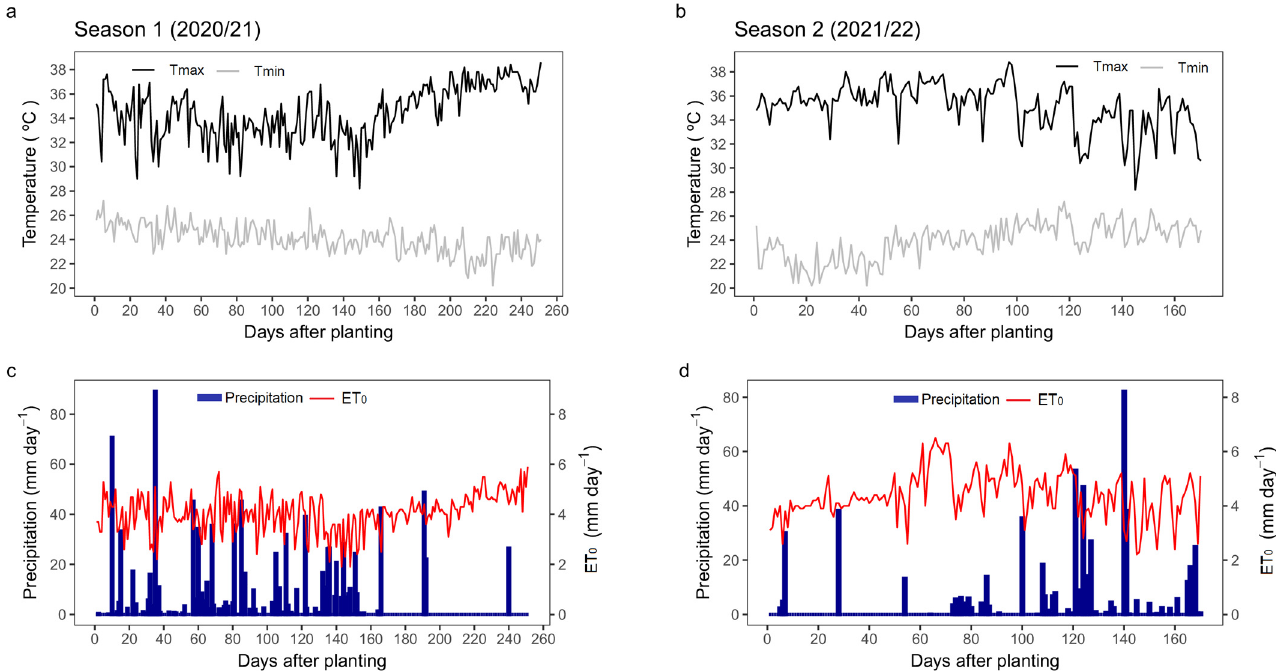
Figure 2. Daily weather data during the experiment for calibration and validation of the AquaCrop model for Megathyrsus maximus cv. Agrosavia sabanera at the Motilonia Research Center (Cesar, Colombia), season 1 from 19 June 2020 to 24 February 2021 and season 2 from 17 December 2021 to 4 June 2022. ( a ) Tmin and Tmax are the minimum and the maximum of daily air temperature in season 1; ( b ) Tmin and Tmax are the minimum and the maximum of daily air temperature in season 2; ( c ) Precipitation and reference evapotranspiration (ET 0 ) in season 1; ( d ) Precipitation and reference evapotranspiration (ET 0 ) in season 2.